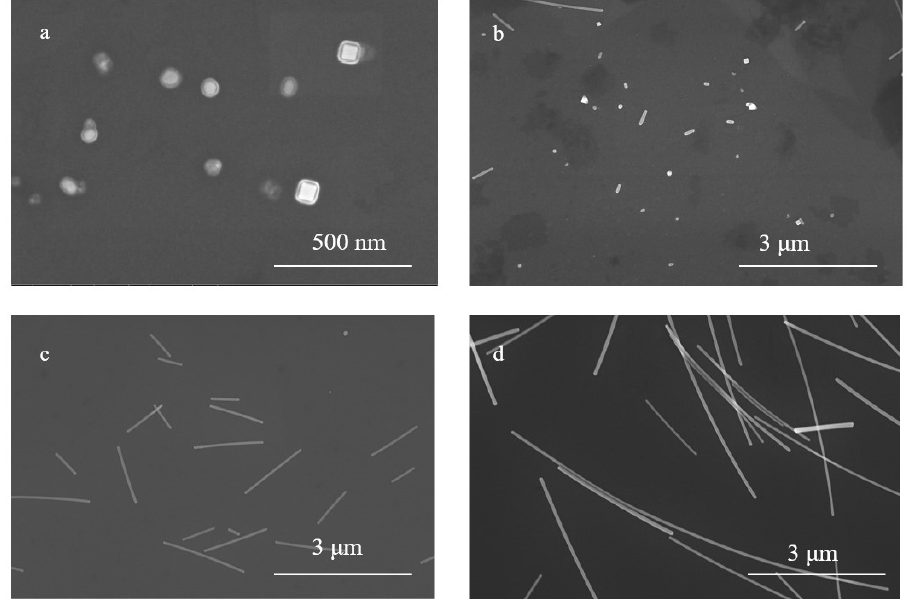
Figure 5. SEM images of AgNWs at 160 °C with TBAC as crystal seed additive at ( a ) 8 min, ( b ) 10 min, ( c ) 12 min, and ( d ) 14 min.